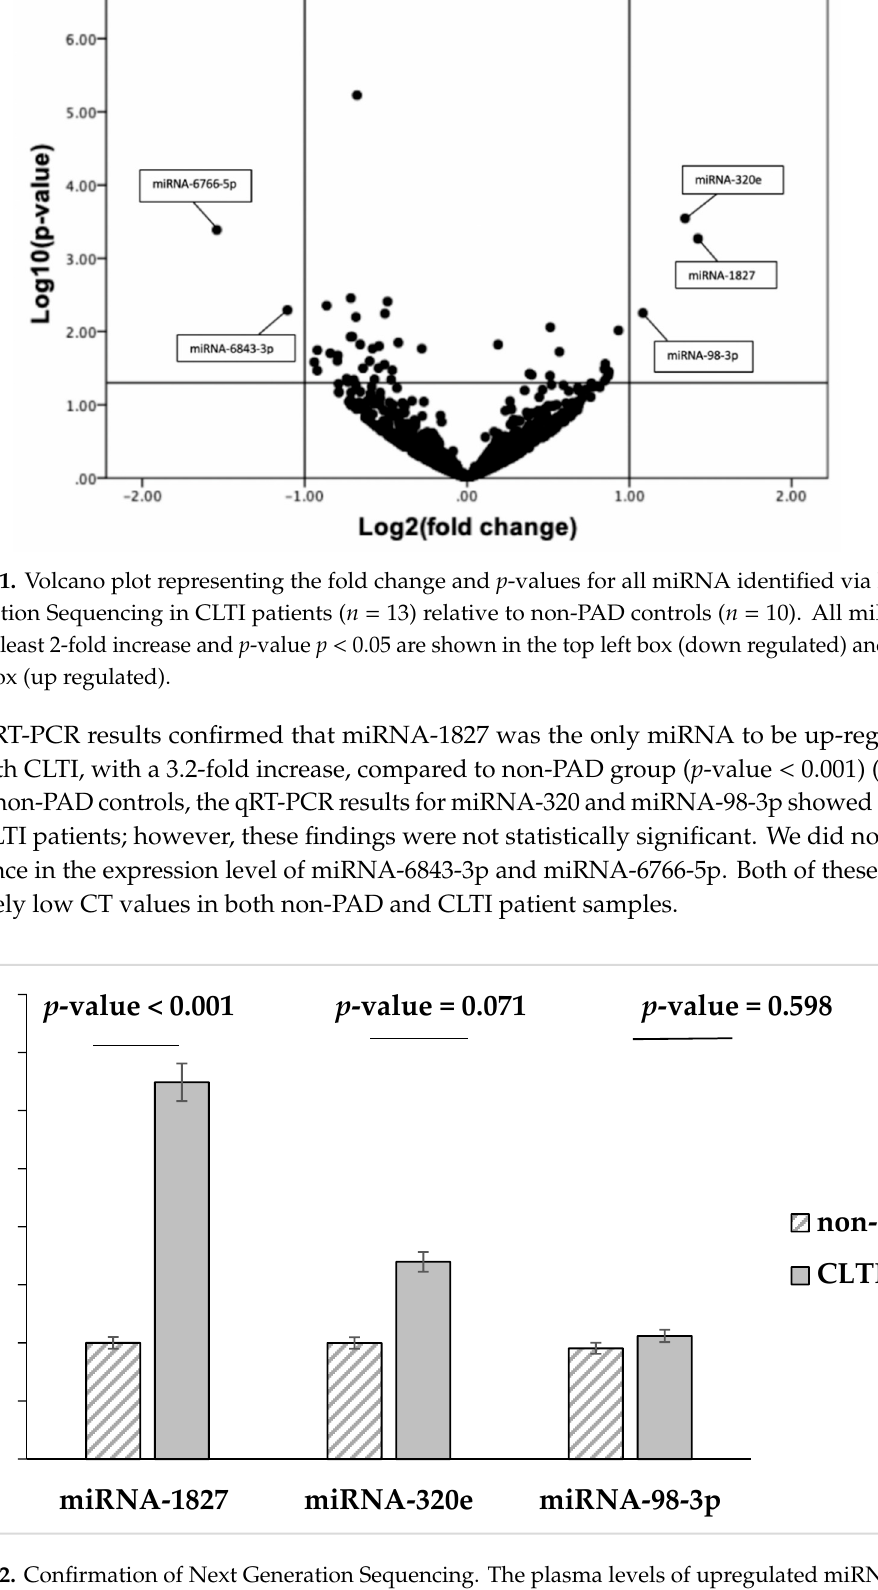
Figure 2. Confirmation of Next Generation Sequencing. The plasma levels of upregulated miRNA in control non-PADs ( n = 20) and CLTI patients ( n = 31) were investigated via qRT-PCR. Compared with miRNA levels in control subjects, only miRNA-1827 showed a statistically significant increase in CLTI patients (3.2 folds, p -value <